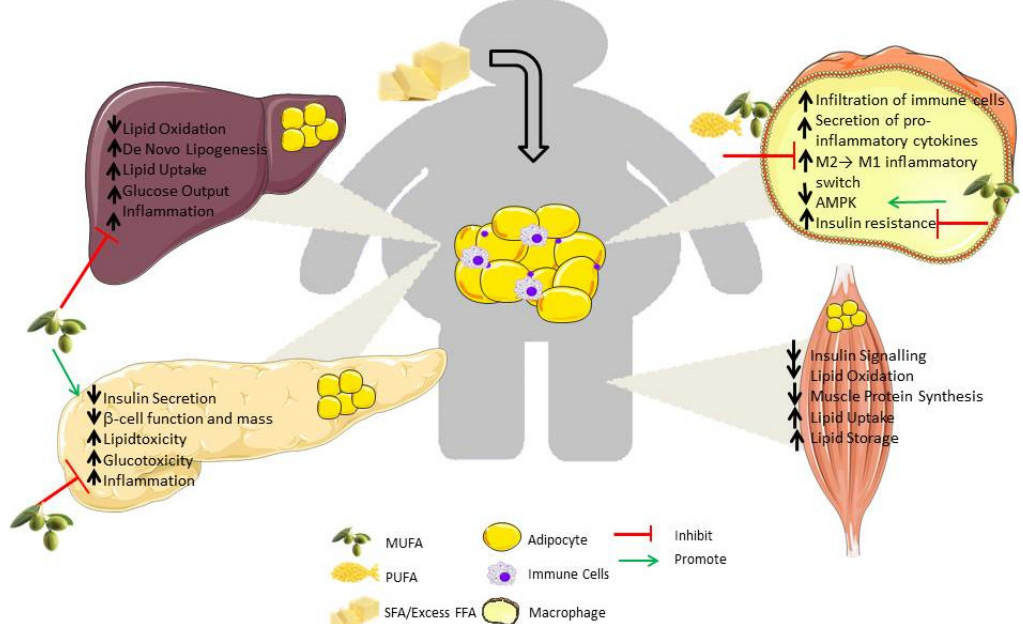
Figure 1. Metabolic ‐ inflammation: Implication of free fatty acid (FFA) driven insulin resistance on the major metabolic organs. As adipose tissue expands due to excess nutrients, immune cells infiltrate causing chronic low ‐ grade inflammation and metabolic changes. Ectopic lipid spill ‐ over from the adipose to the liver, muscle and pancreas results in glucotoxicity and lipotoxicity. All of these disruptions culminate in impaired insulin signaling, dysregulated glucose homeostasis and development of insulin resistance and type 2 diabetes (T2D). Differential modulation by fatty acids occurs, whereby saturated fatty acids (SFA) exacerbate the situation, while monounsaturated fatty acids (MUFA) and polyunsaturated fatty acids (PUFA) reduce this metabolic inflammatory state. (This figure was prepared using the Servier medical art website [4].